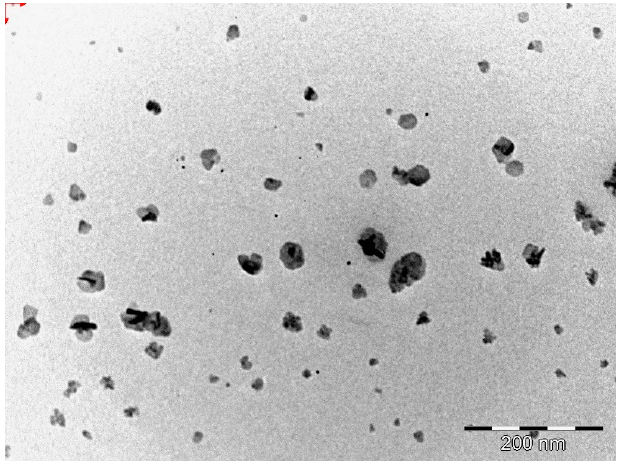
Figure 3. TEM micrograph of optimized EFV-loaded NLC .